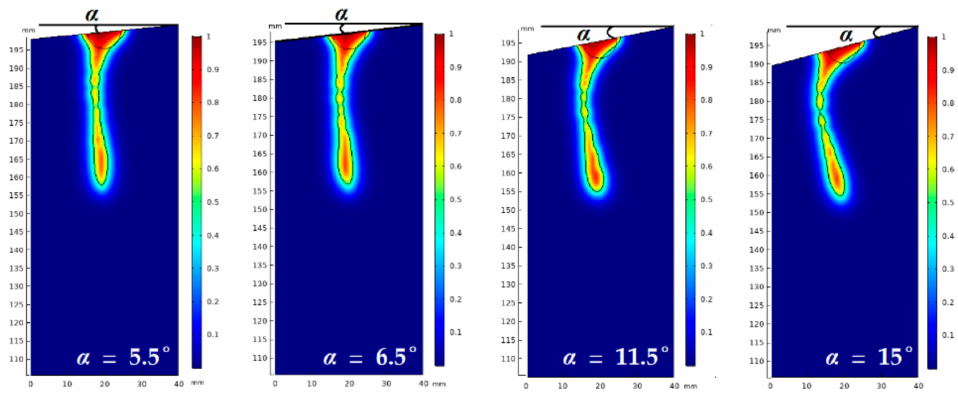
Figure 11. The initial diameter of suspended water-drop.